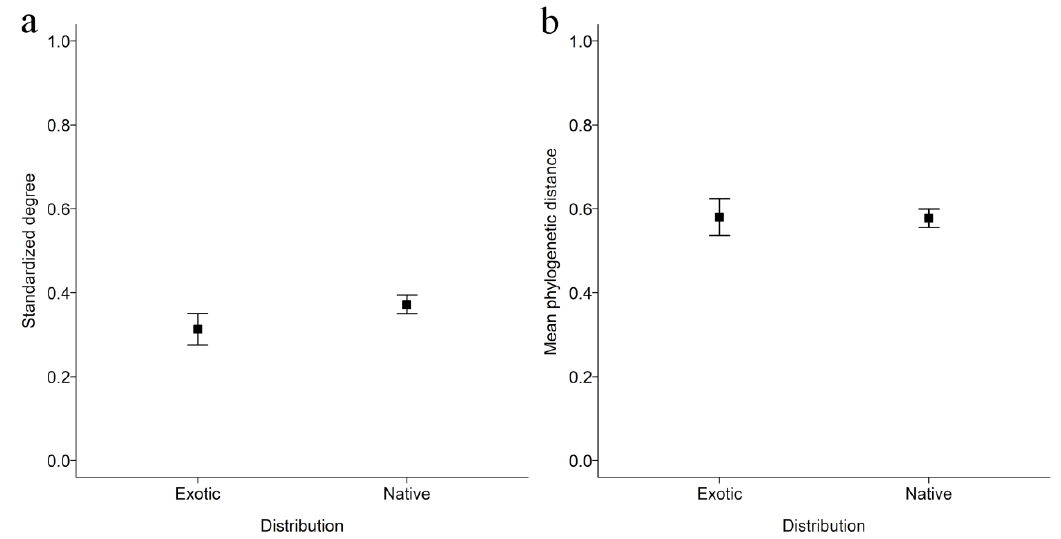
Fig 4 . Effect of distribution on Apis mellifera ’s Linnaeus, 1758 resource use in plant-pollinator networks. Standardized degree of plants used by A. mellifera (a). Mean Phylogenetic distance (MPD) of plants used by A. mellifera (b). Square indicate means and vertical bars indicate standard